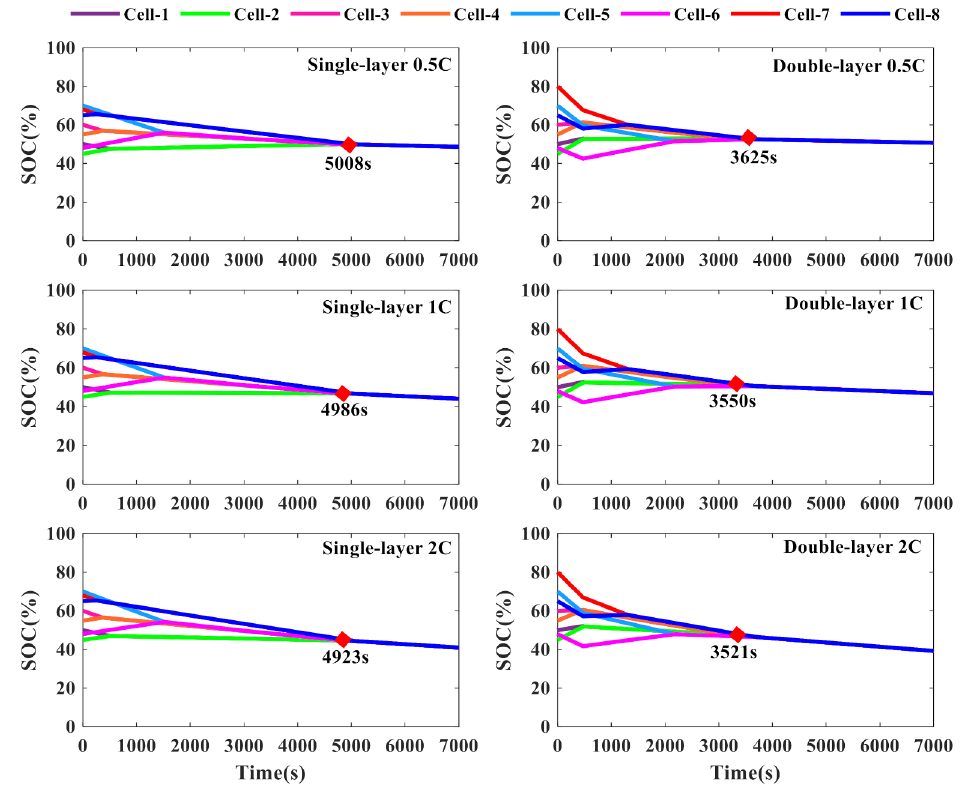
Figure 12. Different charging rate state simulation